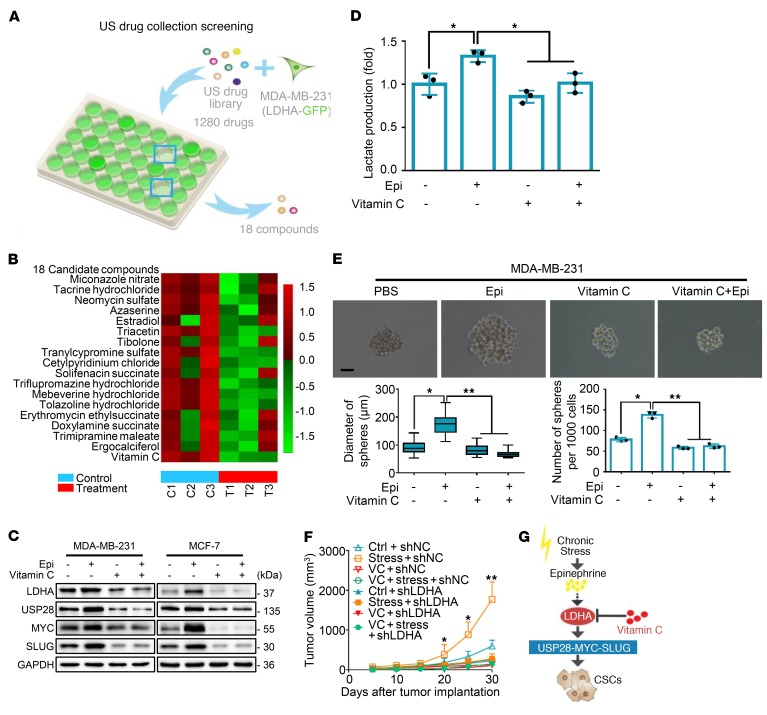
Vitamin C reverses chronic stress–induced breast cancer stem-like properties in vivo and in vitro.(A) US drug collection screening: MDA-MB-231 cells stably expressed with pEGFP-LDHA were treated with 1280 drugs. Fluorescence intensities were examined. n = 3. (B) Representative heatmap of LDHA expression after treatment with the 18 candidate compounds; n = 3. Heatmap colors represent relative LDHA protein levels as indicated by the color key. (C) Immunoblot analysis of MDA-MB-231 and MCF-7 cells treated with vitamin C and/or Epi for 5 days. (D) Lactate levels were examined in the cell culture media of MDA-MB-231 cells in C; n = 3 (Student’s t test). (E) Representative spheroid images formed by single cells with vitamin C and/or Epi; n = 3. Scale bar: 50 μm. Bottom left panel shows distribution patterns of sphere diameter. Bottom right panel shows the number of spheres (d > 50 μm) (1-way ANOVA). (F) Tumor growth curves of indicated treatments of mice; n = 5 (1-way ANOVA). (G) Model of targeting chronic stress–mediated cancer stem-like traits by vitamin C. Data are representative of at least 3 independent experiments. Data represent mean ± SEM; *P < 0.05, **P < 0.01.